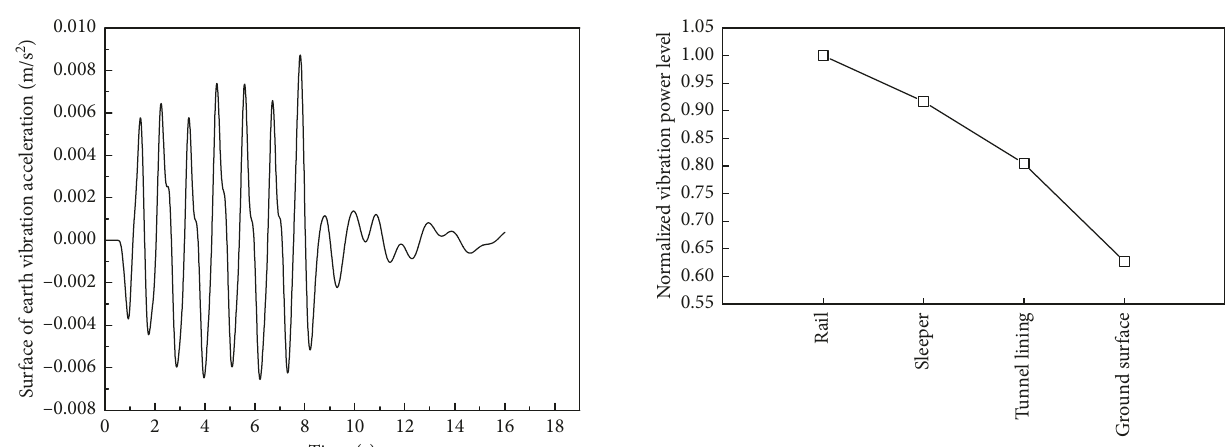
Figure 20: The attenuation of vibration energy in the system.